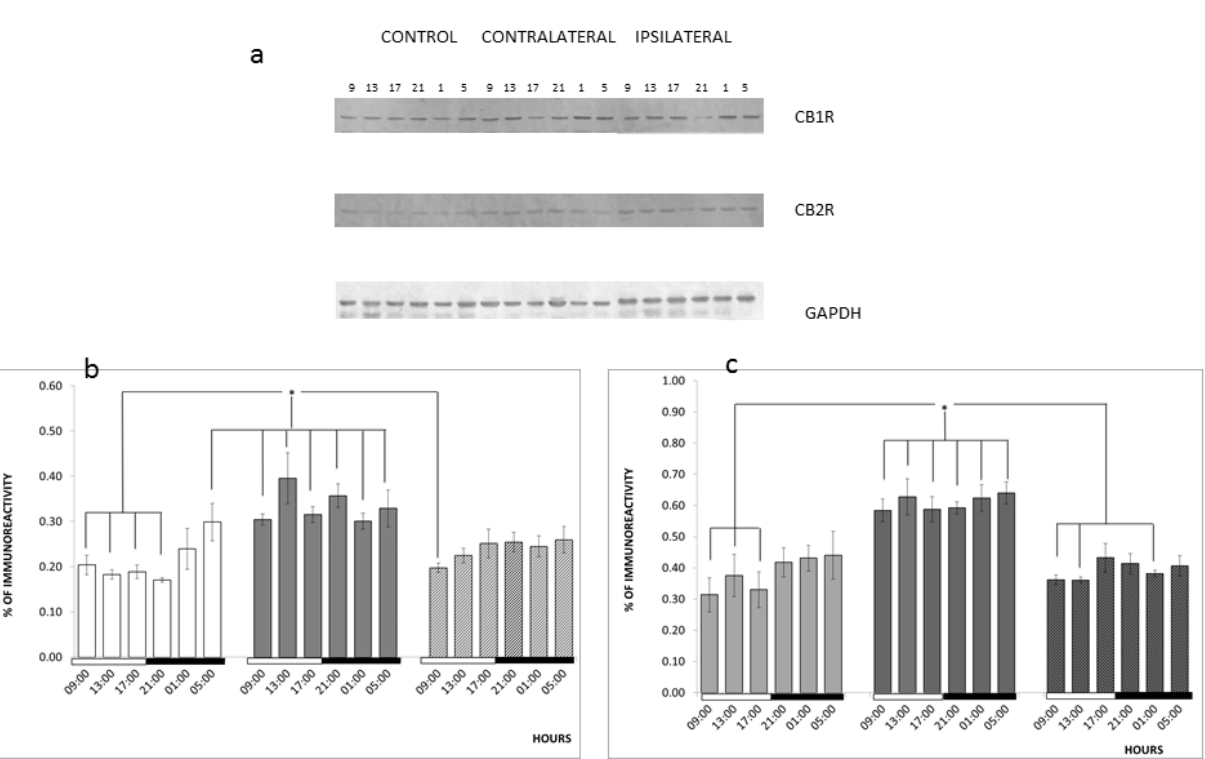
Figure 3. Effects of TBI on CB1R and CB2R expression. ( a ) Representative picture of a western immunoblot of CB1R, CB2R, and GAPDH in the rat cerebral cortex of rats subjected to TBI at different hours of the day; ( b ) Quantification by densitometry of the western immunoblot bands for CB1R. The bars represent mean ± SEM of the ratio of the densitometry for CB1R and GAPDH ( n = 3); ( c ) Quantification by densitometry of the western immunoblot bands for CB2R. The bars represent mean ± SEM of the ratio of the densitometry for CB2R and GAPDH ( n = 3); * p < 0.05. Two-way ANOVA and a Duncan post-hoc